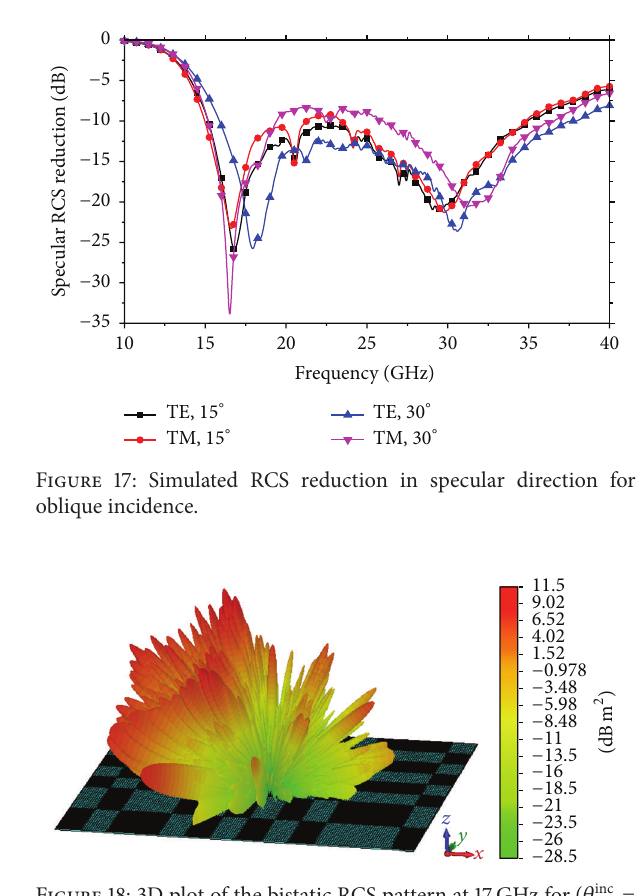
Optimized Phase Layout . The intercepted EM energies were redirected to more directions, so that the scattered fields are controlled in low levels in all directions. A lot of bistatic RCS lobes ( ≫ 4 or 6) are produced in space, leading to a great lobes increases as metasurface size (lattice number) increases; thus the reduced magnitude of monostatic and bistatic RCSs becomes greater. For the metasurface designed based on beams are created in space, and the bistatic RCS reduction reaches 17.6